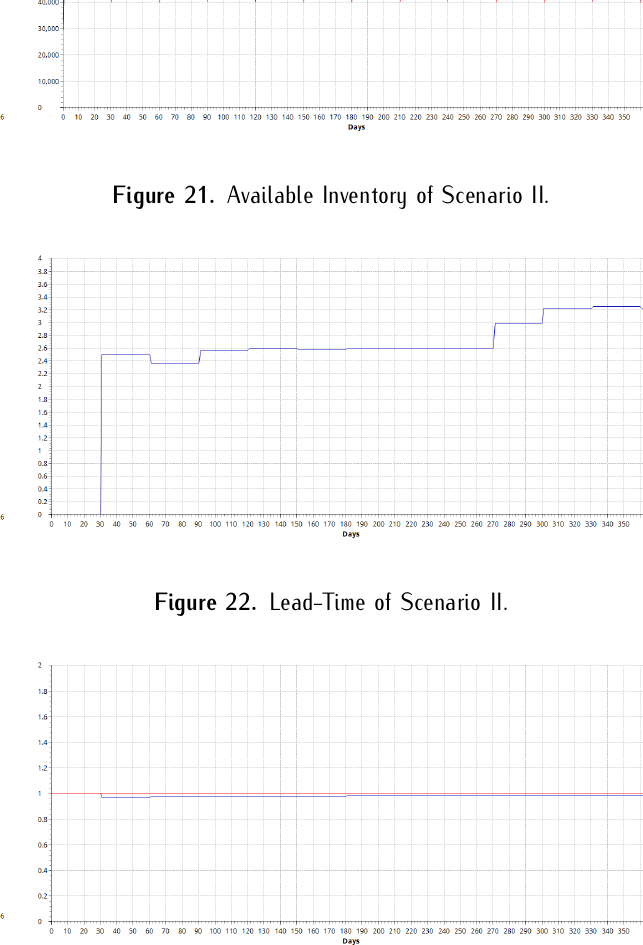
Figure 19. Lead-Time of Scenario I.